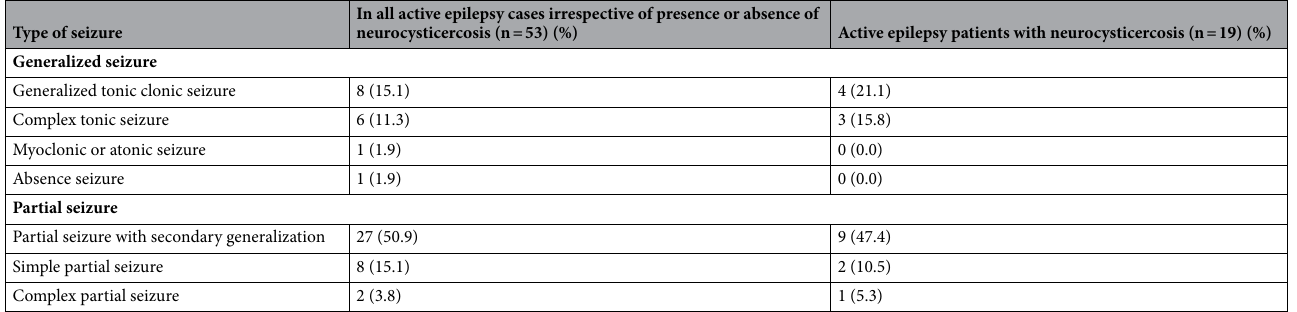
Table 1. Type of seizure among patients with active epilepsy and neurocysticercosis.